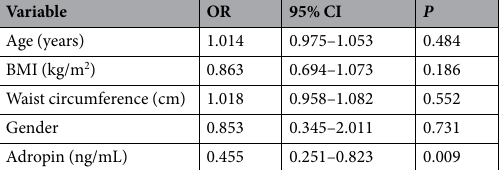
Table 5. Multivariable logistic regression analysis of independent predictors for positive IBD status. Abbreviations: 95% CI- 95% confidence interval; BMI- body mass index; OR- multivariable adjusted odds